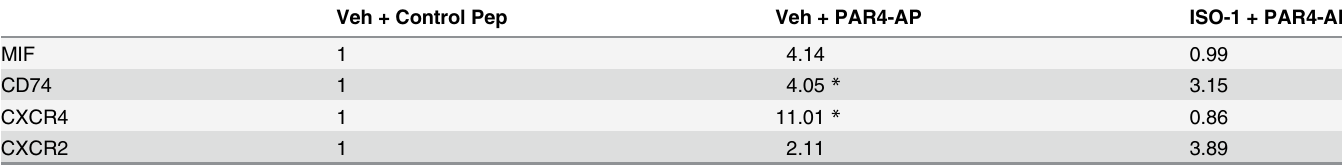
Table 3. Expression changes in bladder MIF and MIF receptors after intravesical PAR4-AP treatment.